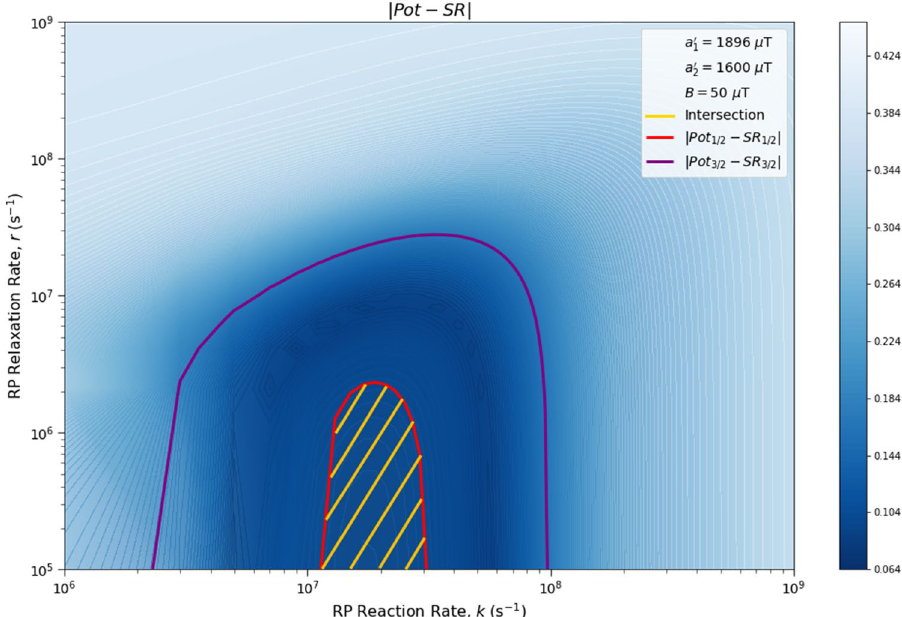
Figure 9. The dependence of the agreement between relative anesthetic potency and singlet yield ratio on r and k for the case where the dominant HFI for electron B is assumed to be with the TrpH ·+ β -hydrogen instead of nitrogen. Here a ′ 1 = 1896 µ T, a ′ 2 = 1600 µ T, and B = 50 µ T. The singlet yield ratio SR is calculated using a 1 = (γ n / | γ 129 Xe | )γ e a ′ 1 , where the magnitude of the isotopic nuclear gyromagnetic correction factor, (γ n / | γ 129 Xe | ) , is normalized for 129 Xe. The model can explain the experimentally derived 6 relative anesthetic potency of xenon where | Pot 1 / 2 − SR 1 / 2 | ≤ 0.08 and | Pot 3 / 2 − SR 3 / 2 | ≤ 0.08 intersect, shaded in yellow.